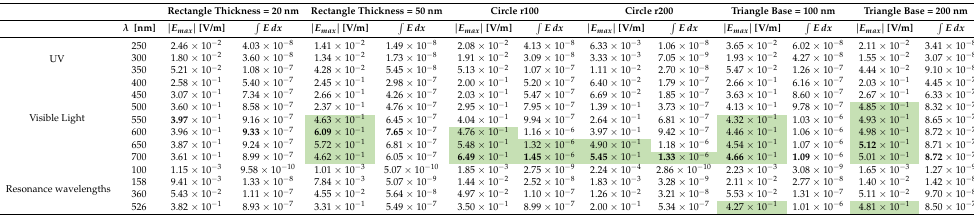
Table A10. Summary table of the results obtained for the copper nanostructures—Probe 1. RectangleThickness=20nm RectangleThickness=50nm